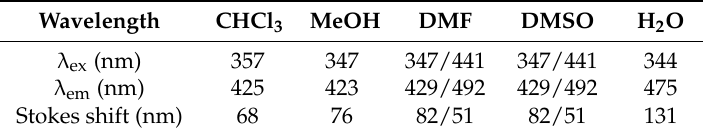
Figure 2. Spectroscopic features of CP3 (1 µ M for fluorescence, 50 µ M for absorbance) in various solvents. Table 1. Spectroscopic values of CP3